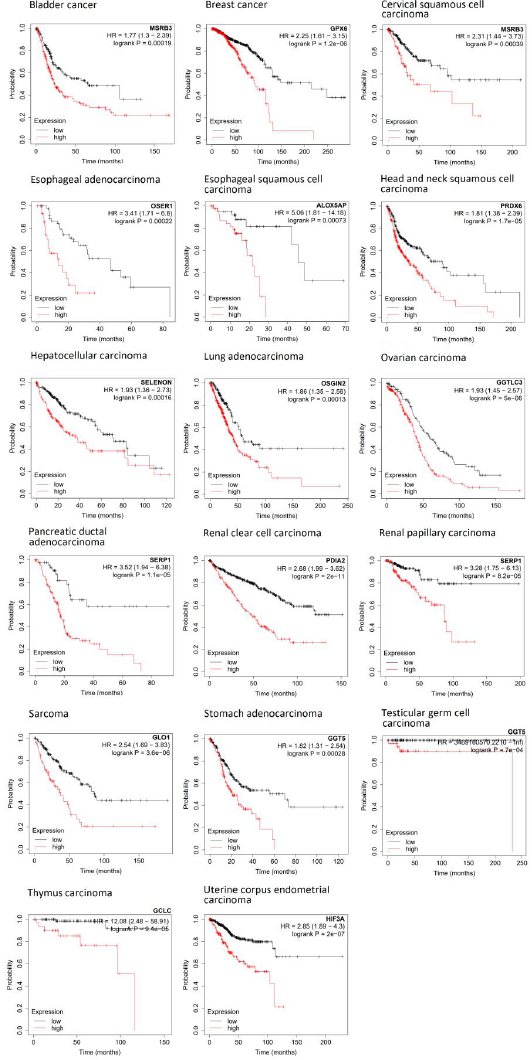
Figure 1. Kaplan – Meier statistics of overall survival for 17 tumor types. Figure 1. Kaplan–Meier statistics of overall survival for 17 tumor